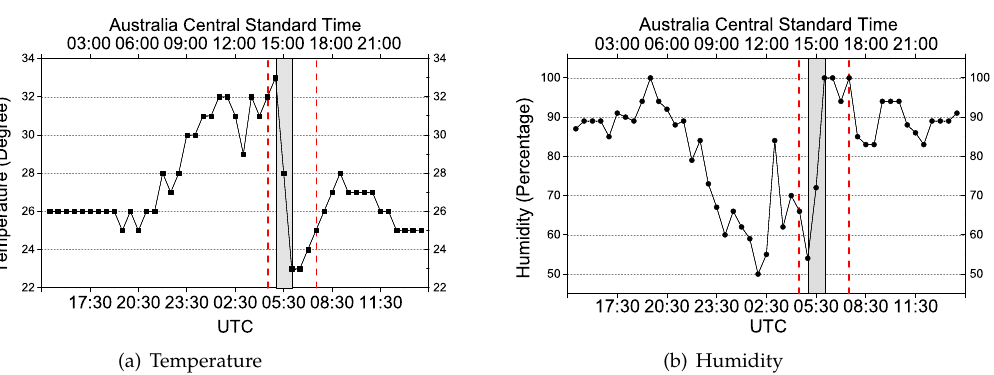
Figure 2. ( a ) Temperature and ( b ) humidity of the corresponding time period of Event